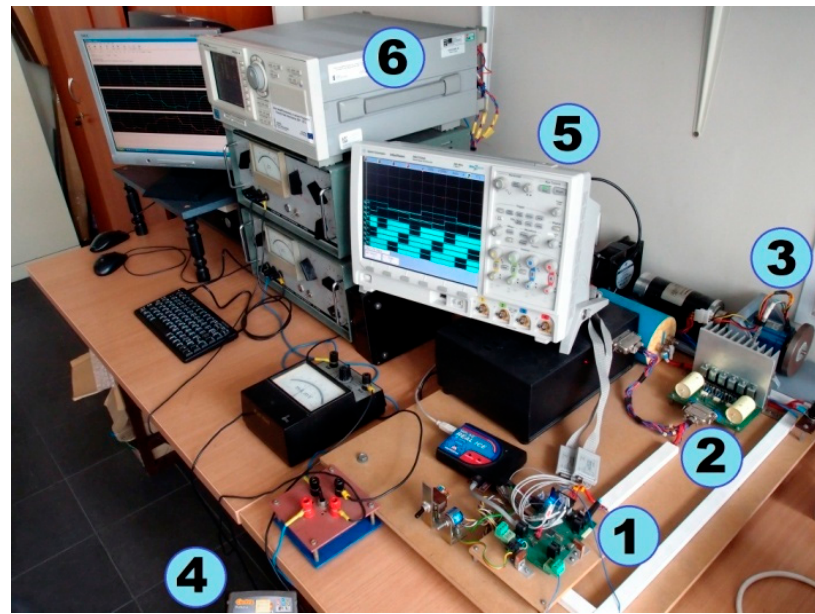
Figure 10. Research station of the two-switch and three-switch converters. The block diagram of the measurement instrument connections is shown in Figure 11.